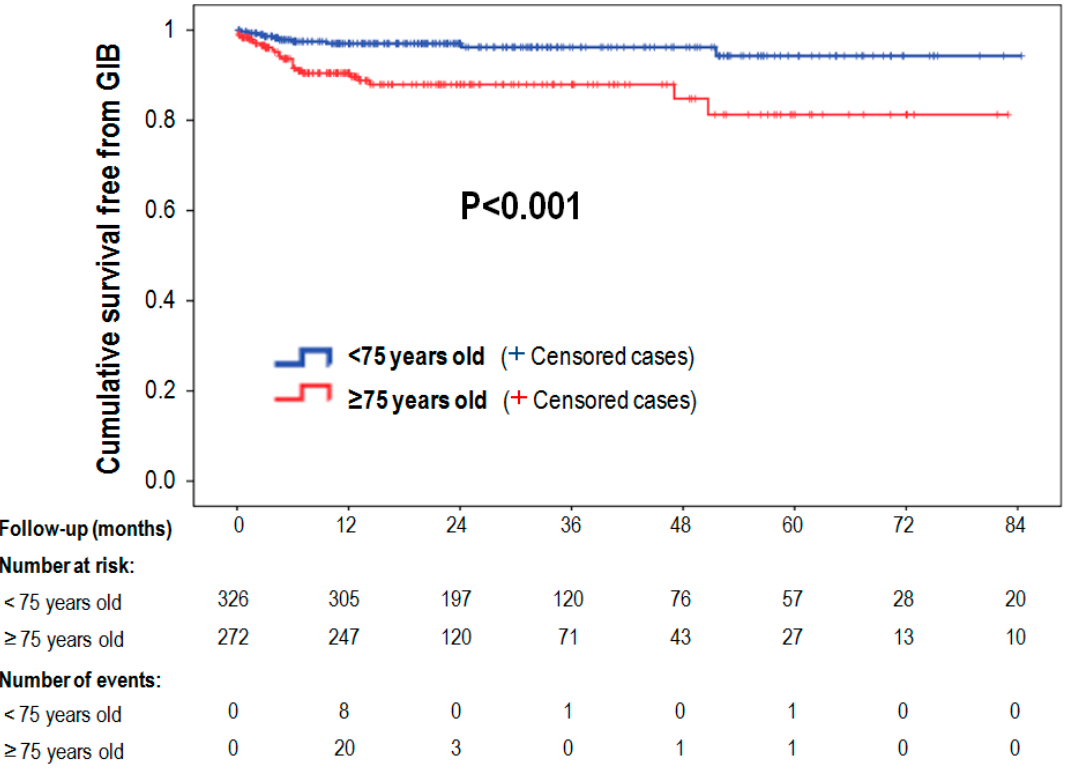
Figure 2. Cumulative survival free from gastrointestinal bleeding (GIB) is significantly higher in patients < 75 years compared to patients ≥ 75 years.